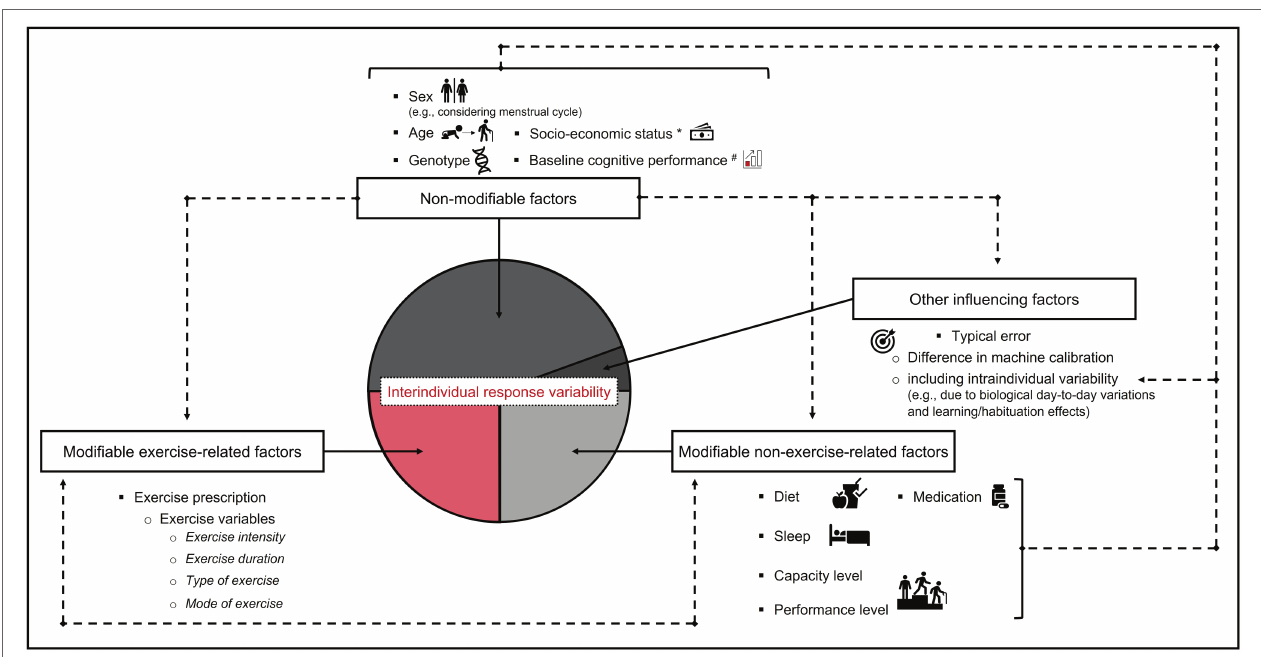
FIGURE 1 | Schematic illustration of the influence of non-modifiable factors, modifiable factors, and other influencing factors that causes interindividual response variability in neurocognitive outcomes after an acute bout of physical exercises. Please note that some factors contributing to interindividual response variability mutually influence each other and that the used ratio of the segments presented in the pie chart does not necessarily reflect the actual proportion of their influence. Dashed lines indicate that these factors have an influence on other factors. Capacity level is defined as the actual or potential ability of an individual (e.g., athlete) to accept load. The capacity level is influenced by various factors, including fitness status before load, loading rate, psychological factors, and various other internal and external factors (Soligard et al., 2016). Here, we included performance level as fitness status, as a specific domain of capacity in an organismic subsystem or an external load outcome parameter. *Socio-economic status including factors such as (parental) income, (parental) education, and (parental) occupation. # Baseline cognitive performance refers to the baseline performance capabilities of individuals with respect to a specific cognitive task that can be, among other factors, influenced by perceptual skill level, socioeconomic status (SES), and the global cognitive performance. Please note that socio-economic status and baseline cognitive performance are not completely non-modifiable but certain aspects cannot be changed in later life periods (e.g., developmental trajectories influenced by parental income and parental education that shaped cognitive performance in